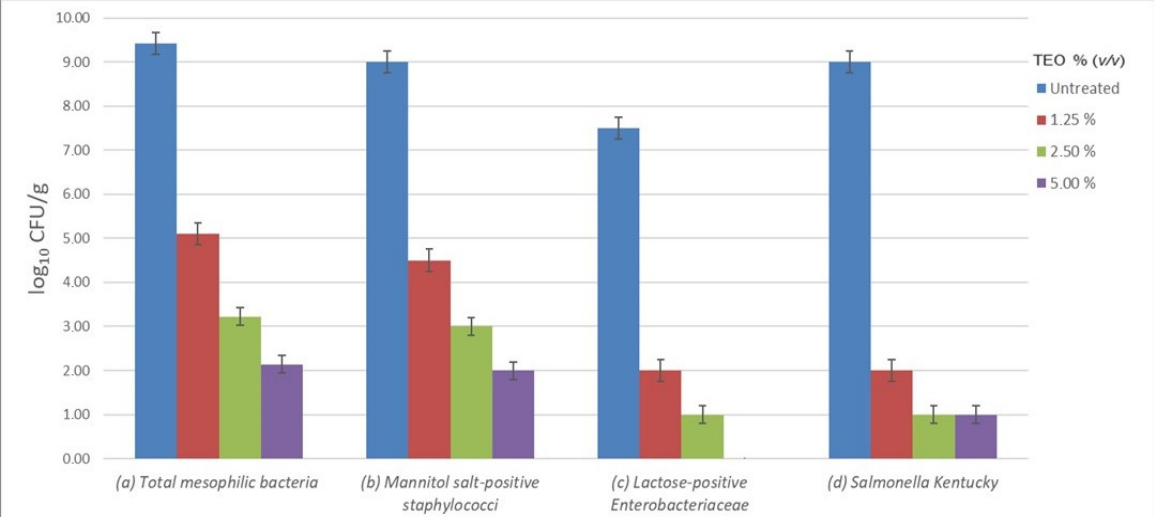
Figure 1. Bacterial growth of the tested strains in poultry litter treated with different concentration ( v / v ) of TEO after 24 h of incubation, compared to positive